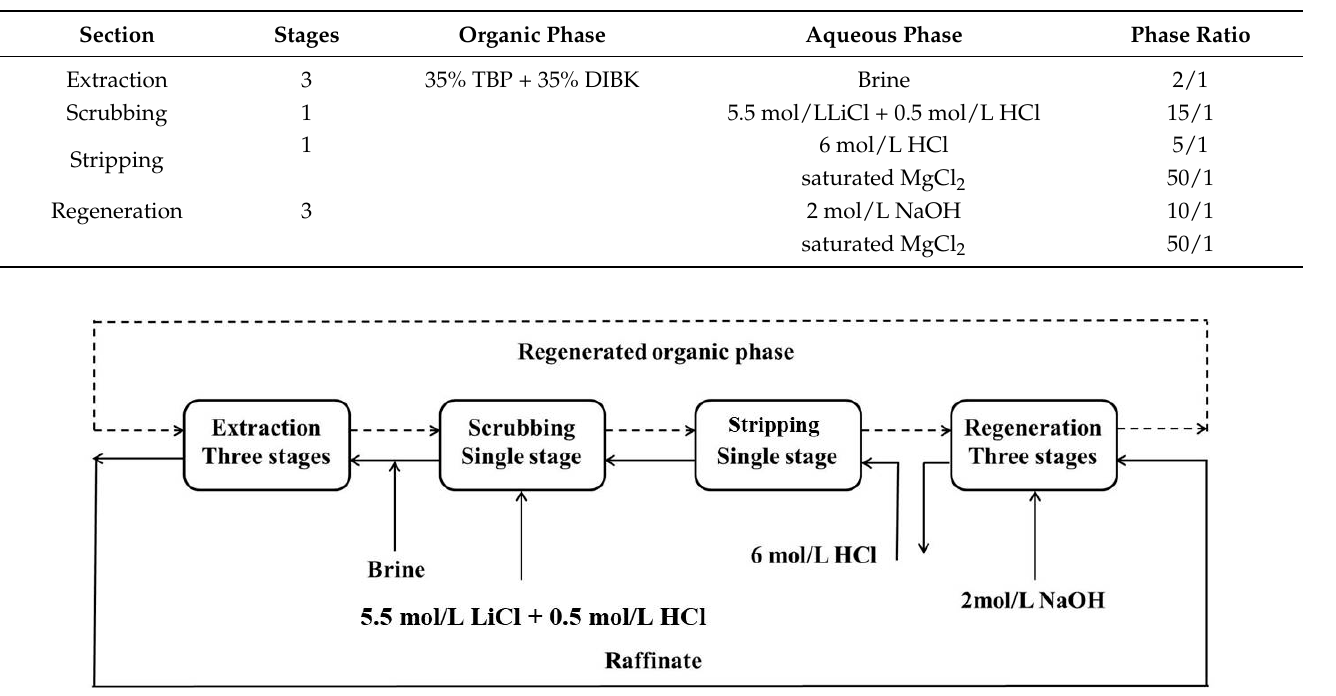
Figure 9. Process diagram of counter-current extraction.